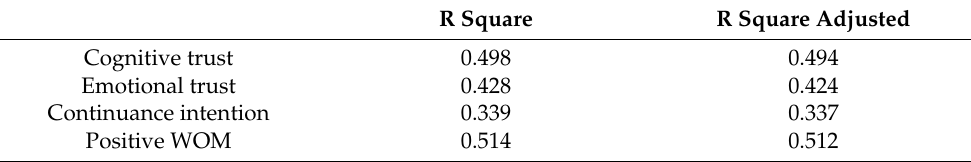
Table 8. Results of R 2 and adjusted R 2 .